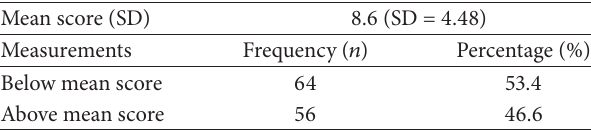
Table 2: Arabic-translated version of the D-Lit